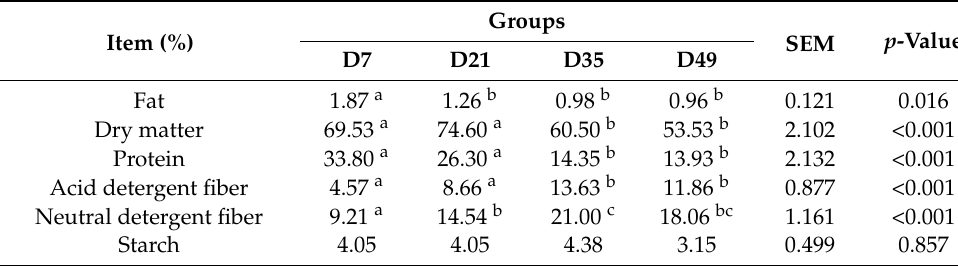
Table 6. Nutrient contents of feces at different sample